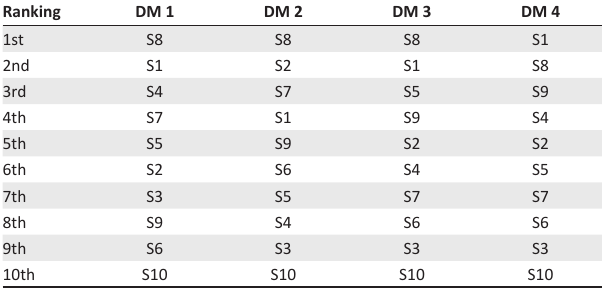
TABLE 8: Ranking of service providers by four decision-makers.